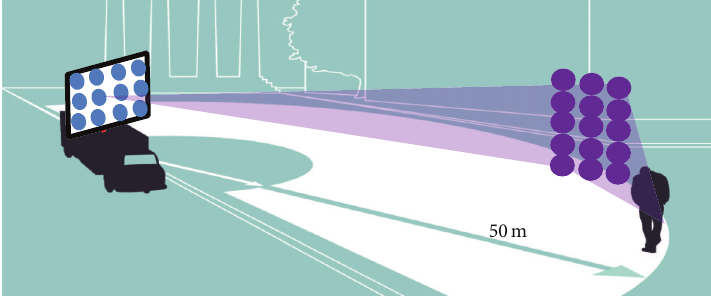
Figure 1: General sketch of our van-based, high resolution radar system for standoff detection of potential suicide bombers. The circles in the vicinity of the person under test represent the passive reflecting surfaces used to enhance the field of view and resolution of the imaging system.